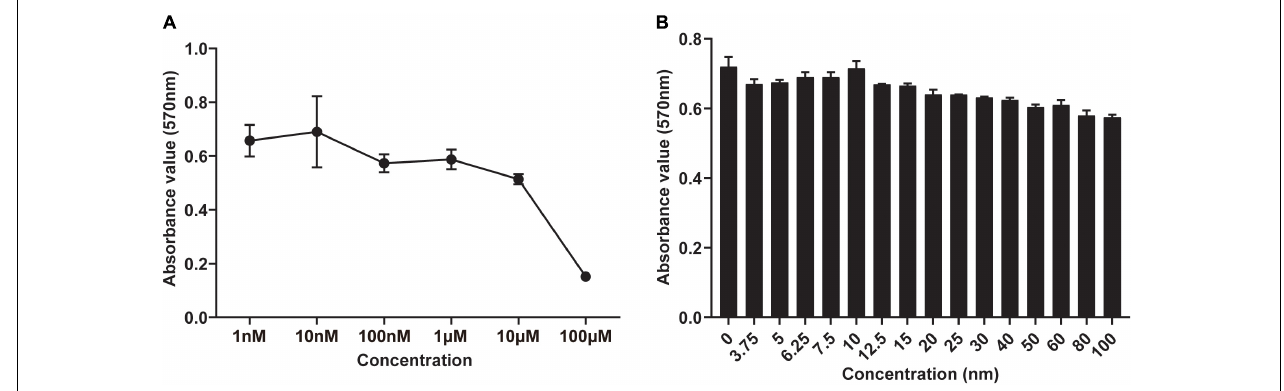
FIGURE 1 | Screening of the optimal concentration of DHEA in the viability of hBMSCs by MTT assay. (A) The viability of hBMSCs was measured after 3 days of co-culture with DHEA at various concentrations (0–100 µ M). (B) The viability of hBMSCs was measured after 3 days of co-culture with DHEA at multiple concentrations (0–100